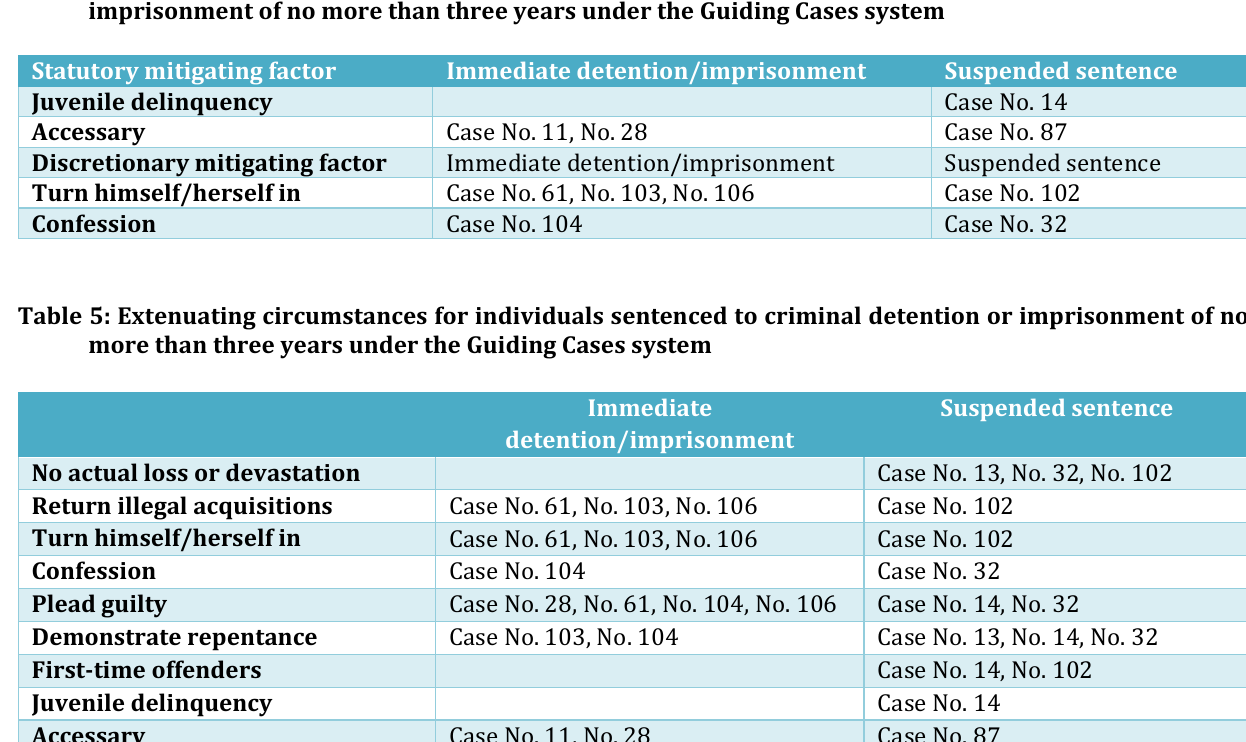
Table 4: Statutory and discretionary mitigating factors for individuals sentenced to criminal detention or imprisonment of no more than three years under the Guiding Cases system